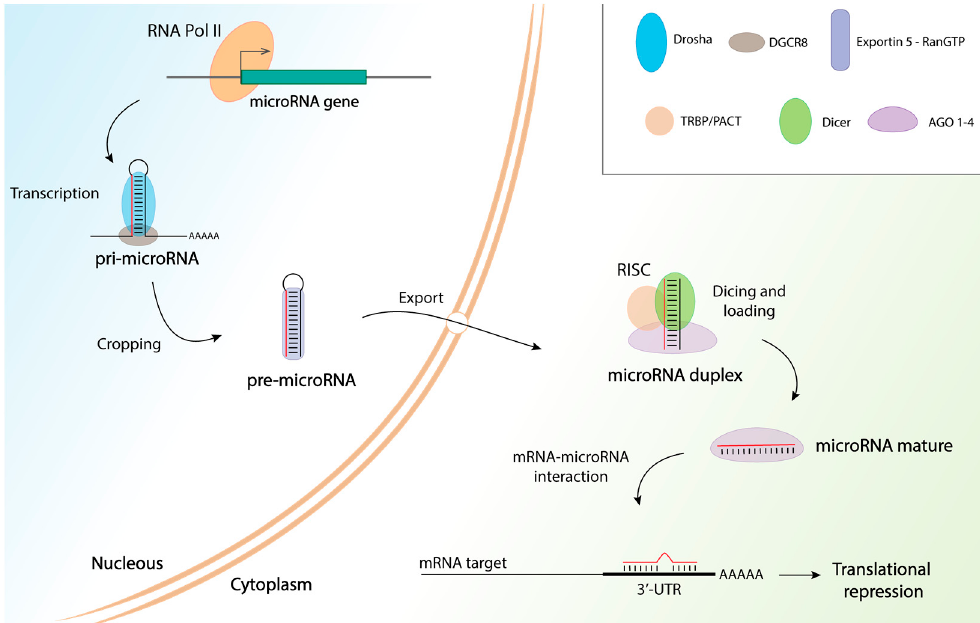
Figure 1. MicroRNA biosynthesis pathway. MicroRNAs (miRNAs) are transcribed by RNA polymerase II (Pol II) activity to generate the primary transcripts (pri-miRNAs). miRNA production is a two-step process involving nuclear cropping and cytosolic dicing processes. First, pri-miRNA cleavage is mediated by a processing complex comprising the RNase III, Drosha, and DiGeorge syndrome critical region 8 (DGCR8), which is also known as the microprocessor complex. This generates a hairpin-shaped pre-miRNA, which is recognized by nuclear exportin 5 and is exported to the cytoplasm where the RNase III, Dicer, cleaves pre-miRNA into 22-nucleotide miRNA duplexes. One strand from the cleavage is degraded. Dicer, TAR RNA-binding protein (TRBP), protein kinase R-activating protein